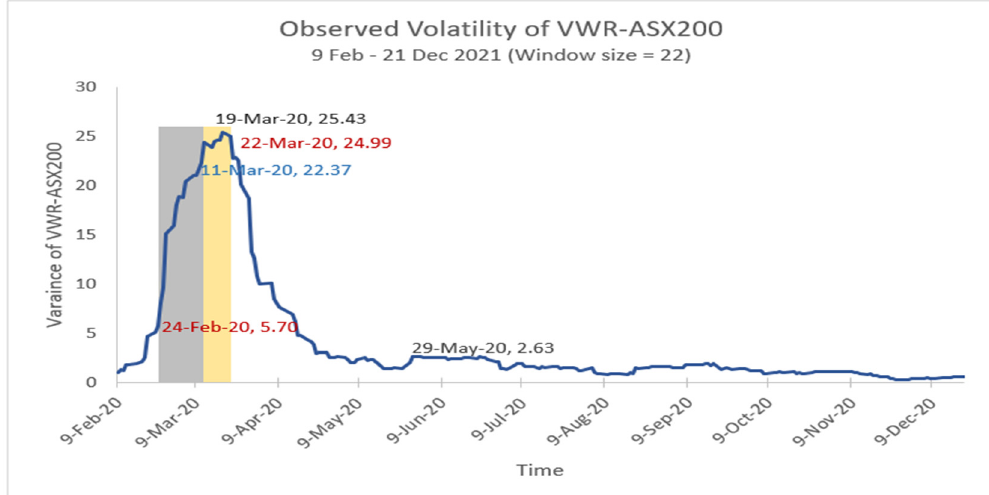
Figure 1. Panel A shows the daily realised VWR of S&P/ASX200 from 27 January 2020 to 30 December 2020. It